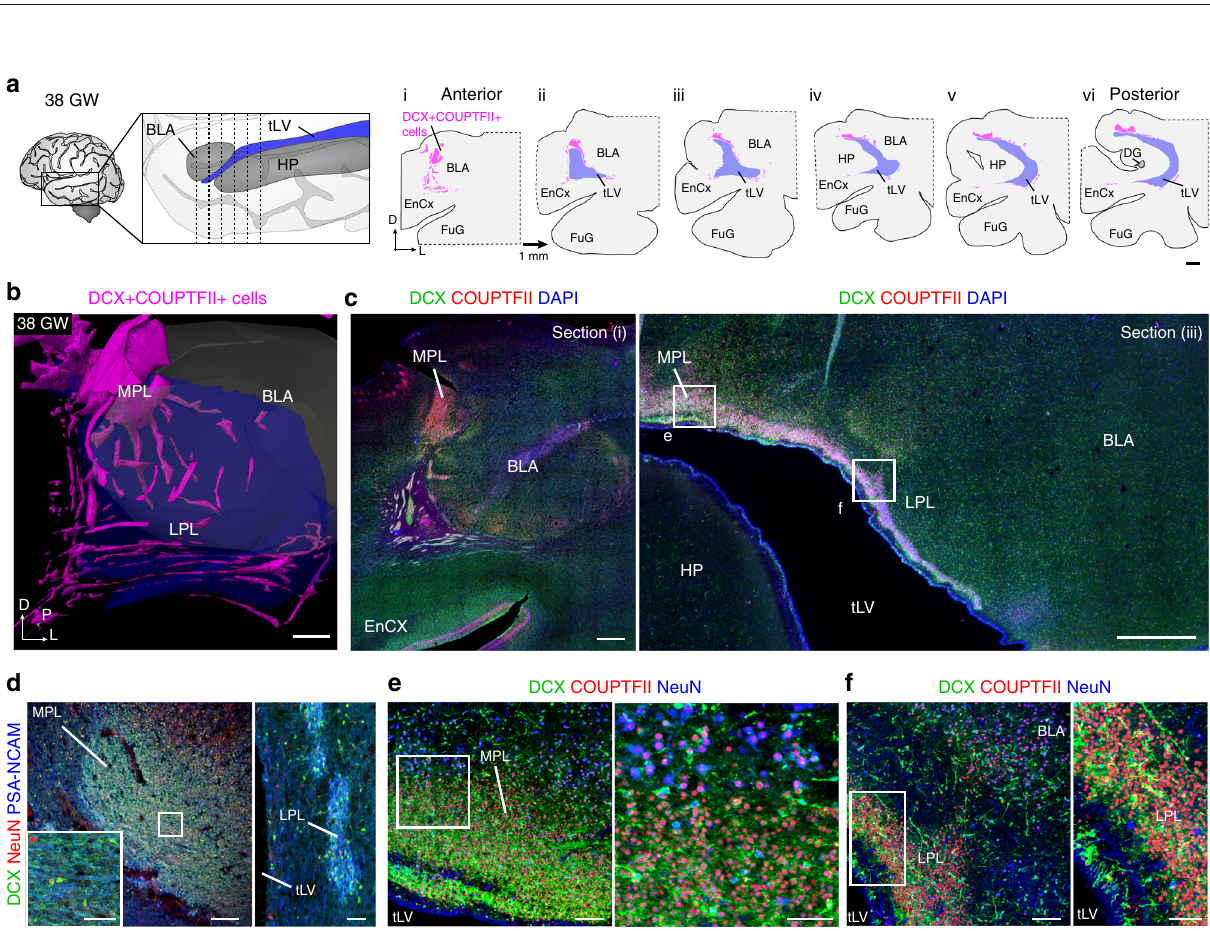
Fig. 2 Distribution of DCX + COUP-TFII + cells in the PL at birth. a Schematic of 38 GW temporal lobe indicating approximate level of coronal sections separated by 1 mm. Maps of the locations of dense clusters of DCX + COUP-TFII + cells on the medial and ventral sides of the amygdala beginning at the anterior tip of the temporal lateral ventricle (tLV) corresponding to coronal section (i). b 3-D reconstruction of DCX + COUP-TFII + clusters (purple) around and within the BLA (gray). c DCX + COUP-TFII + cells in the PL at anterior and posterior levels (i and iii). d DCX + PSA-NCAM + cell clusters are